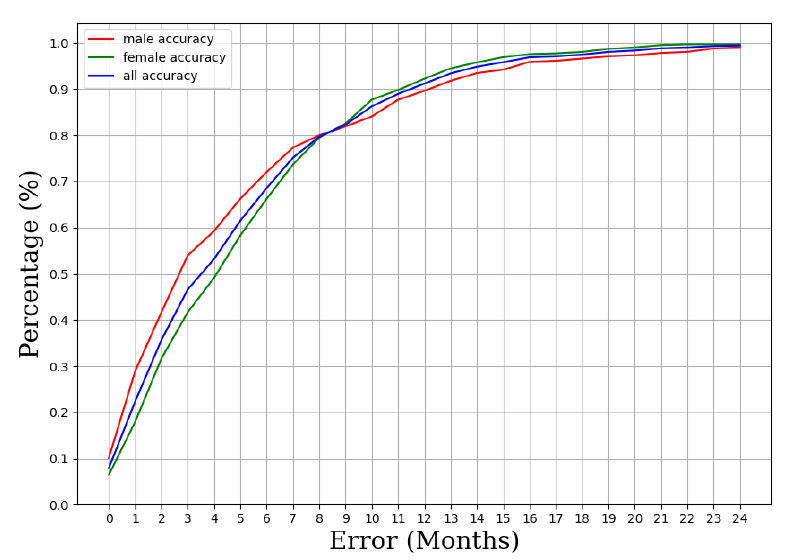
Figure 9. The cumulative percentage accuracy curve to evaluate BAA